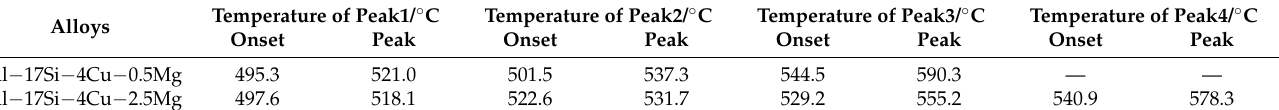
Figure 3. DSC heating curves for the semisolid Al−17Si−4Cu−xMg alloys. Table 2. DSC remelting characteristics of the as-cast alloy samples.